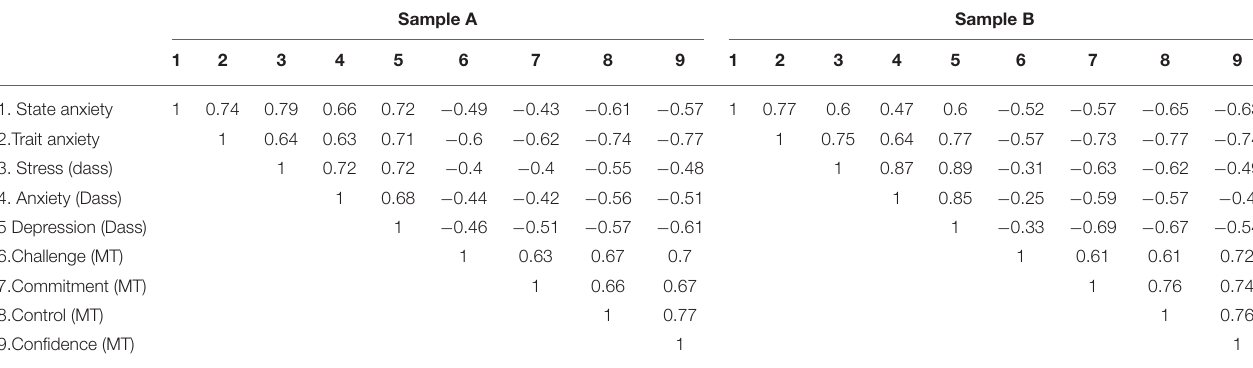
TABLE 3 | Correlations between continuous